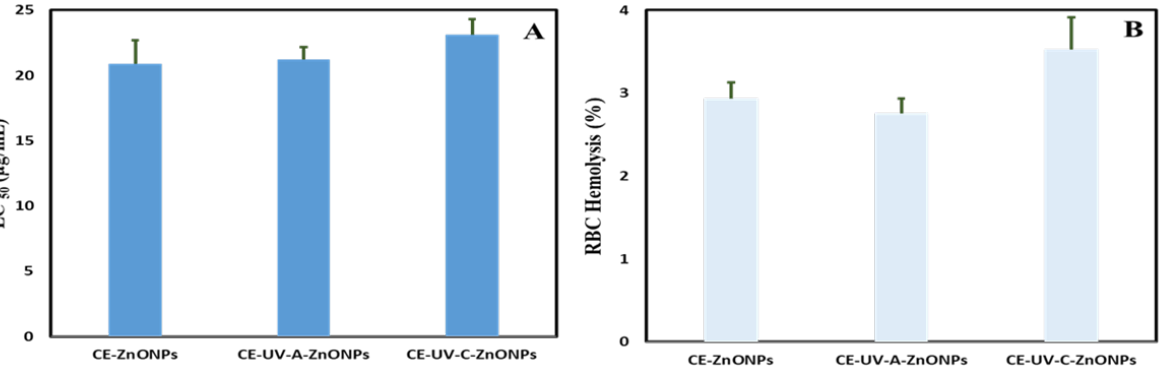
Figure 9. Biocompatibility studies of green-synthesized ZnONPs ( A ) Lethality of ZnONPs against brine shrimp ( B ) Biocompatibility of ZnONPs with human red blood cells (hRBCs).